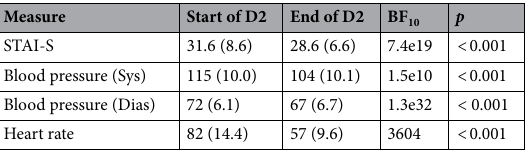
Table 2. Blood pressure, heart rate and state anxiety at the start of the day 2 session versus 90 min after propranolol